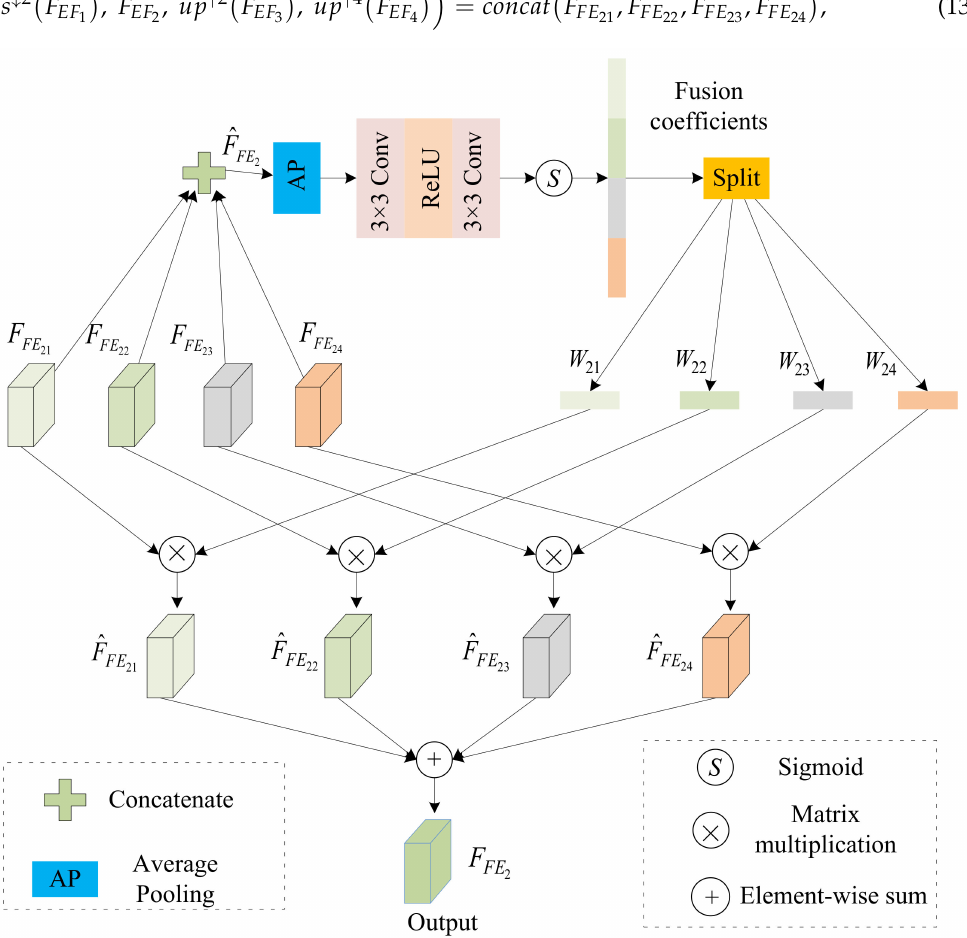
Figure 5. Adaptive fusion